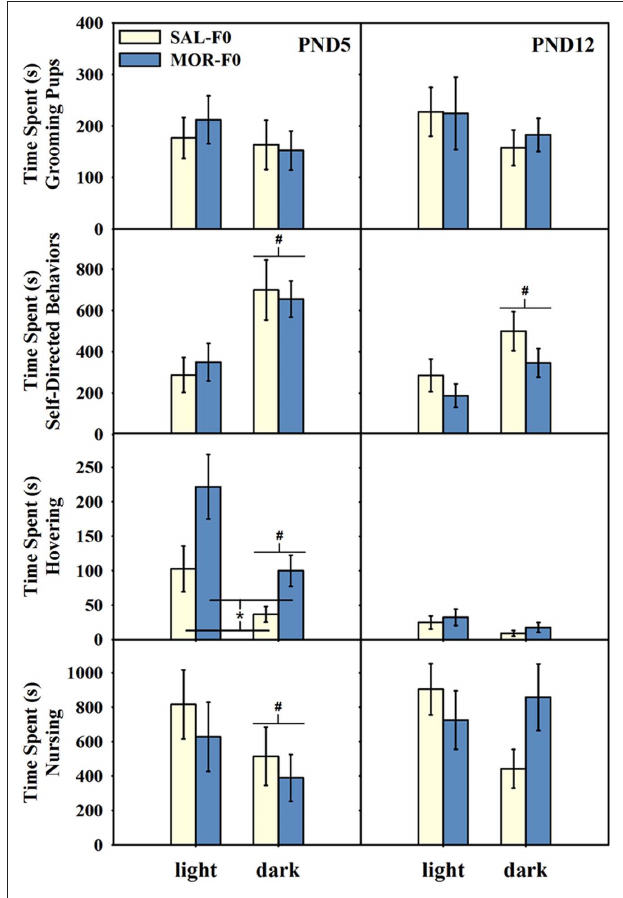
Figure 3 | Mean ( ± SeM) time (seconds) engaged in pup-directed and non-pup-directed activities on PND5 (left panels) and PND12 (right panels). Behavior was recorded at 0800 hours (light phase) and 2000 hours (dark phase). # p < 0.01 as compared to light phase collapsed across adolescent exposure groups. * p < 0.01 MOR-F0 compared to SAL-F0 collapsed across light cycle phase. N = 11 SAL-F0; N = 10